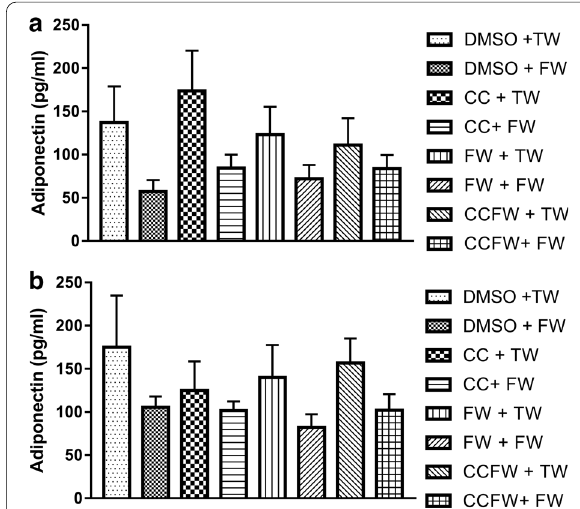
Fig. 2 Changes in plasma adiponectin concentration at post-natal day 63 of a male and b female rats administered curcumin during suckling. Data expressed as mean SEM, n 7–9 per group. Using ± = ANOVA and Bonferroni post hoc test, there were no differences ( p > 0.05) in the plasma adiponectin concentration of the rats across the treatment groups. DMSO TW 10 ml kg − 1 of a 0.5% dimethyl + = sulphoxide solution as neonates and plain tap water